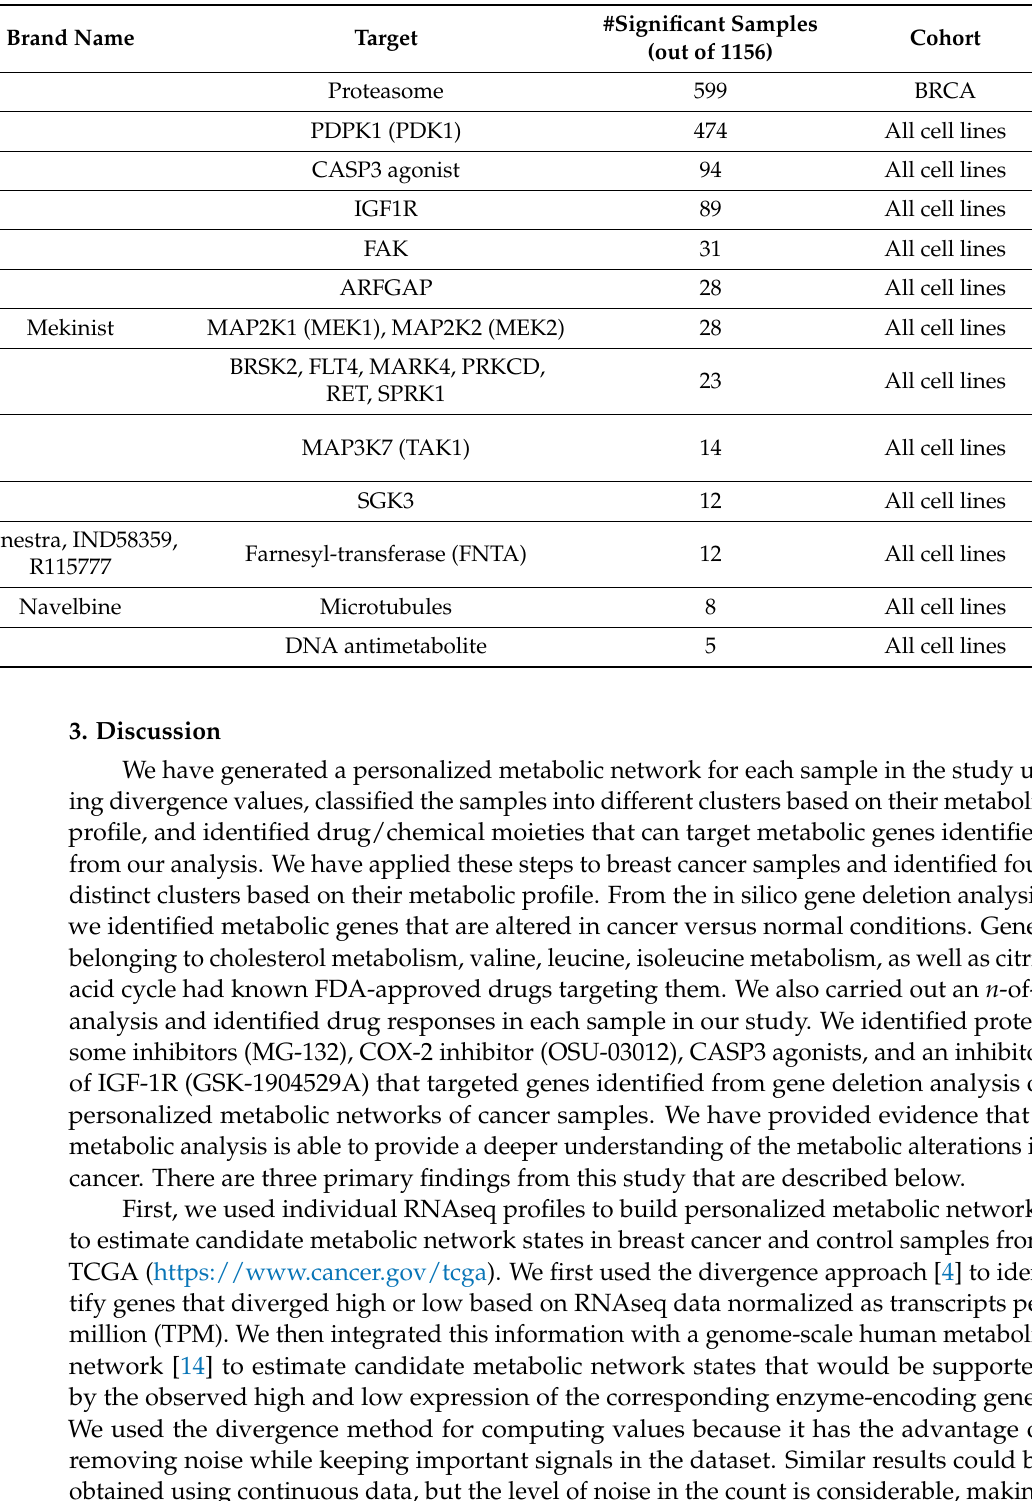
Table 2. Information about drugs ranked based on their influence on genes identified from our in silico analysis. The target information and the number of samples in which these genes are observed are also indicated in the